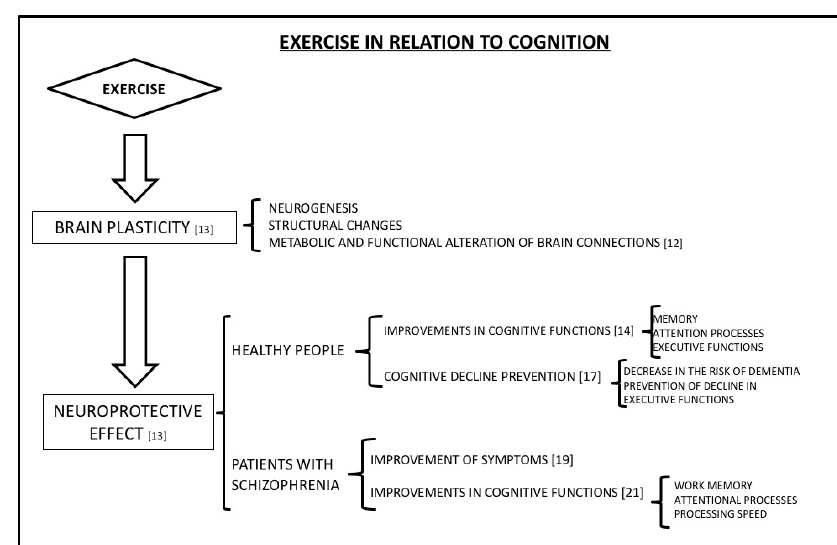
Figure 1. Exercise has a potential role in brain plasticity that leads to a neuroprotective effect in healthy people and in patients with schizophrenia. This neuroprotective effect has positive consequences in the improvement of cognitive functions, in the delay of cognitive deterioration, and in the improvement of the symptomatology of schizophrenia.